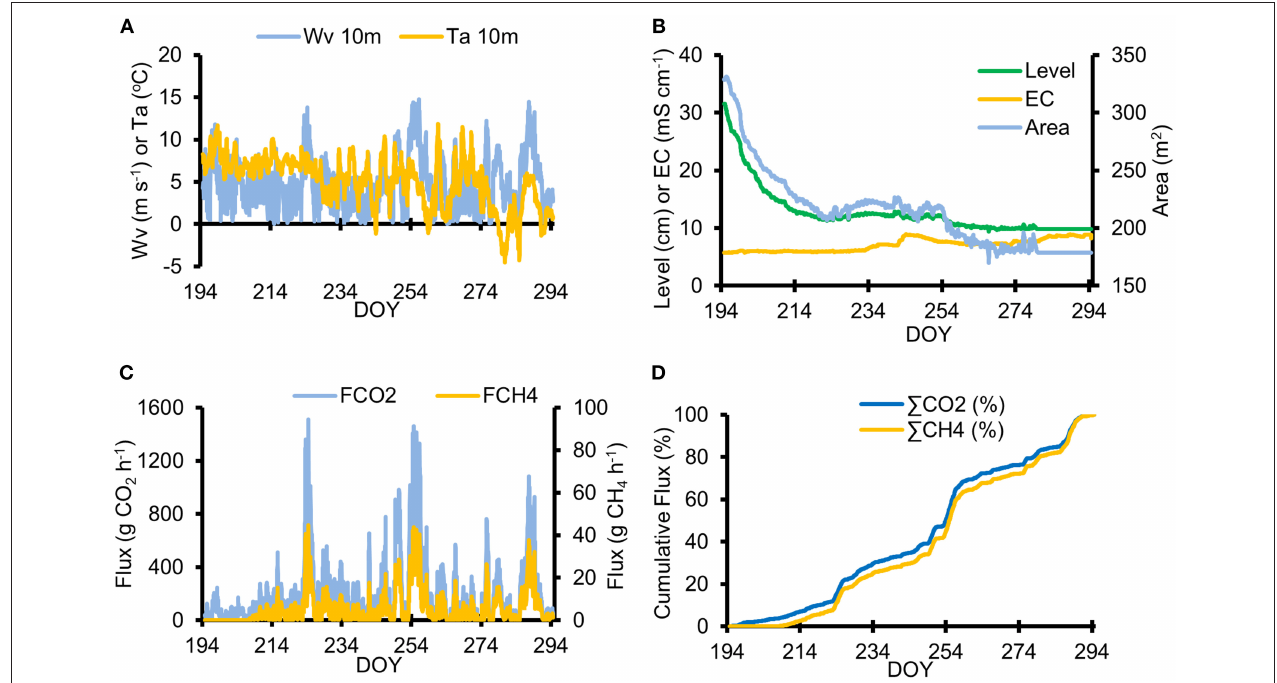
FIGURE 3 | Hourly meteorological conditions and modeled CH 4 and CO 2 evasion fluxes from 13th July (DOY 194) until 21st October (DOY 294) 2017. (A) Wind velocity and air temperature at 10m elevation (“WV” and “Ta,” respectively); (B) pond level (“Level”), area (“Area”) and electrical conductivity (“EC”); (C) Evasion flux of CO 2 and CH 4 (FCO 2 and FCH 4 , respectively), and (D) Percentage distribution of the cumulative evasion flux of both gases [“ P CO 2 (%)” and “ P CO 2 (%)”].